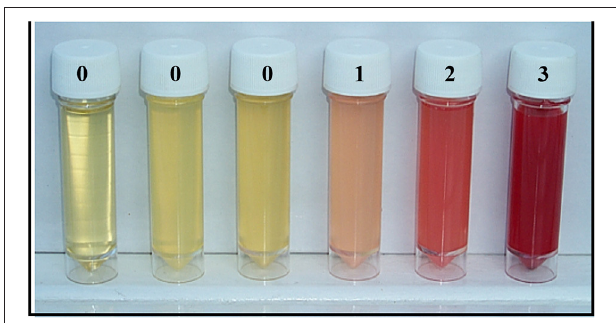
FIGURE 2 | Urine color card for visualization of macrohaematuria.